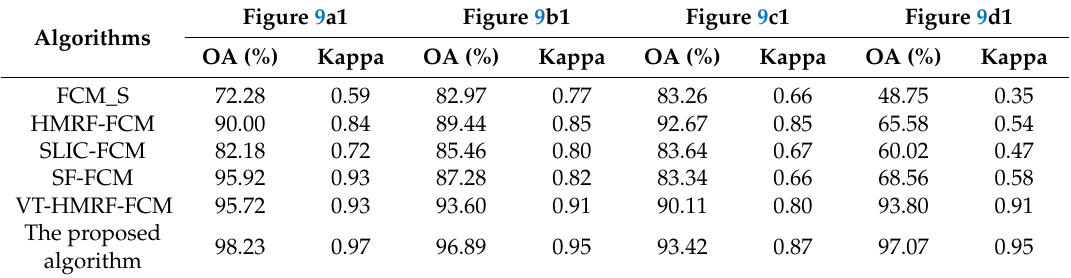
Table 4. Quantitative evaluation of multispectral remote sensing images segmentation